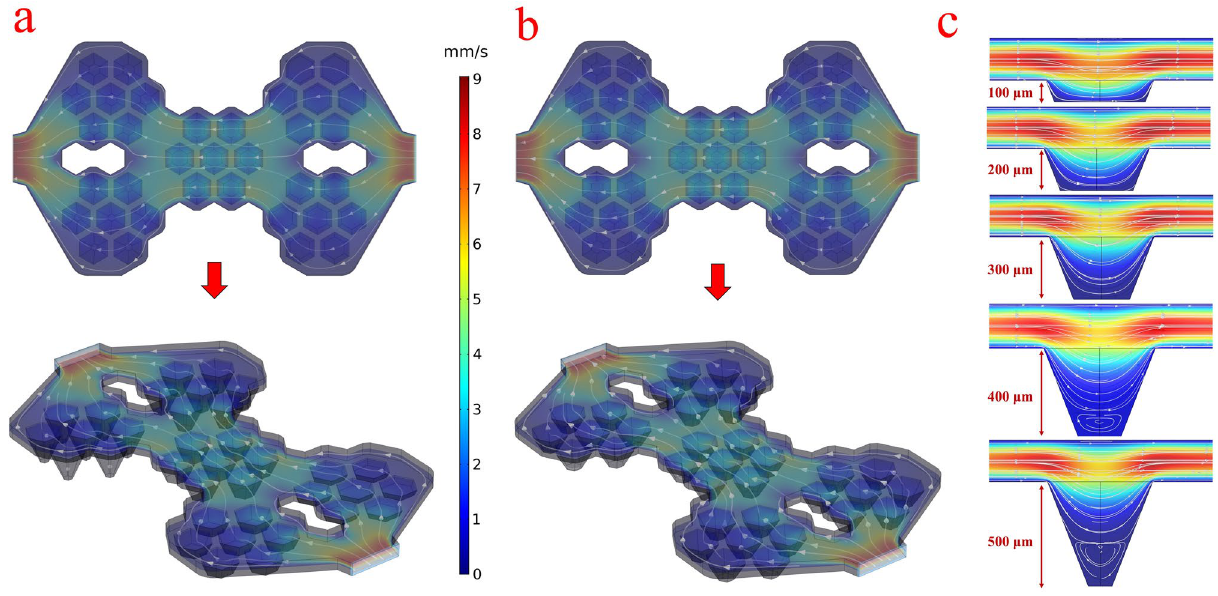
Figure 7. Numerical fluid flow simulation. ( a , b ) The velocity distribution and streamline of the fluid flow inside the chamber and microwells for two chips with variable depth microwells and 300 μm depth microwells. ( c ) The cross-section of the velocity distribution and streamline of the fluid flow inside the microwells. [This figure was created by COMSOL 5.1 (www.comso l.com)].